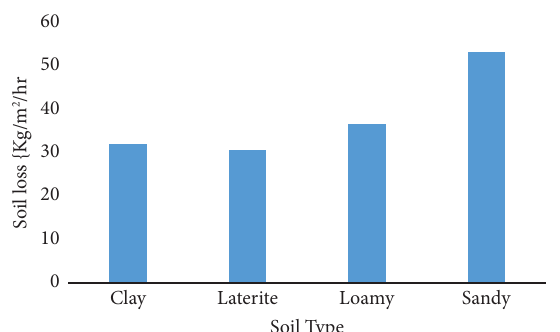
Figure 4: Cumulative soil loss (minus control) in each